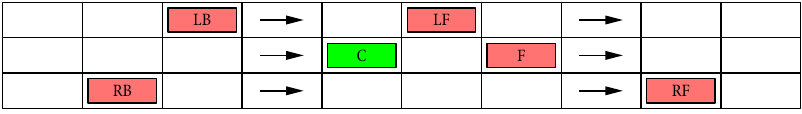
Fig. 3. Locations of adjacent vehicles